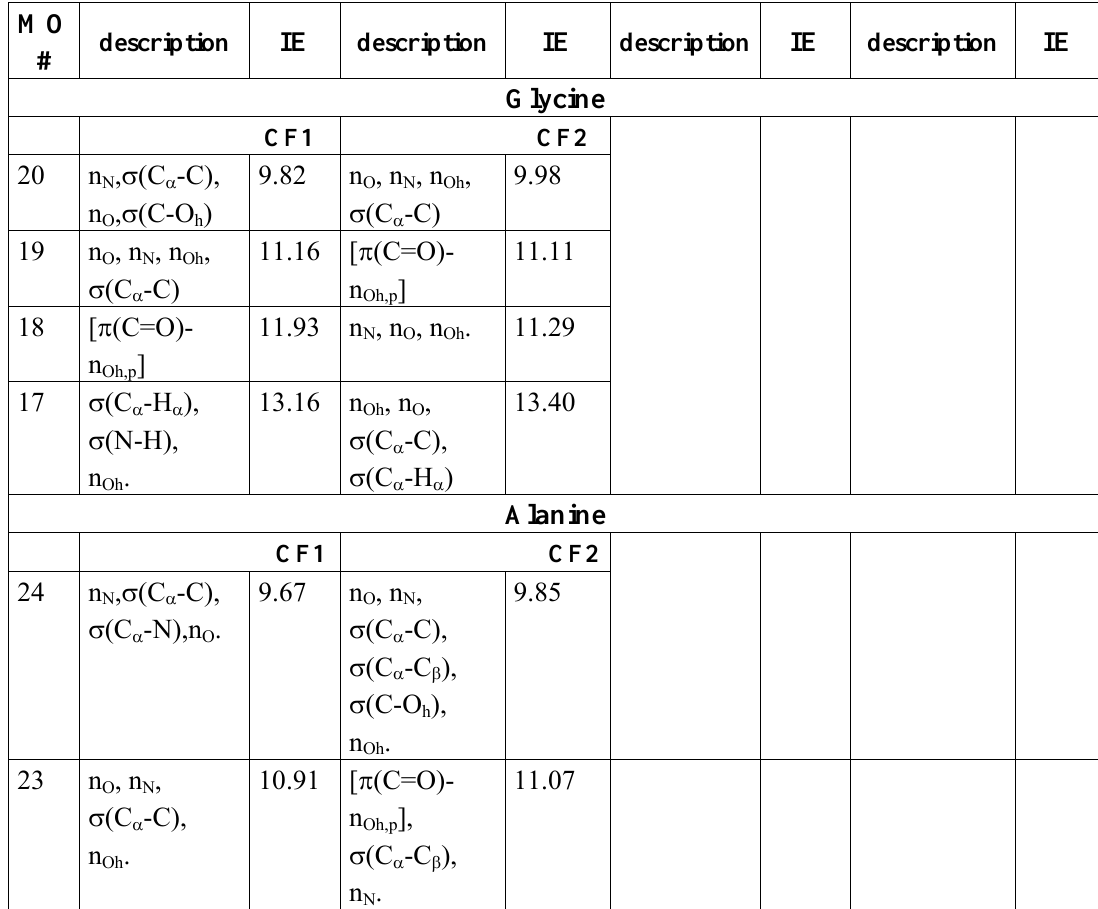
Table 4: Vertical ionization energies IE(eV) calculated by the OVGF(w) approximation, for eighteen α -L-amino acids in several low-lying conformations. The MO window used in the calculation contains all the occupied valence MO and an equal number of virtual ones (see text). The description of the ionized MO relies on a RHF calculation and lists the main features of the MO in decreasing order. Abbr.: σ ’s(sdc)= σ bonds on several C- C and C-H of the side